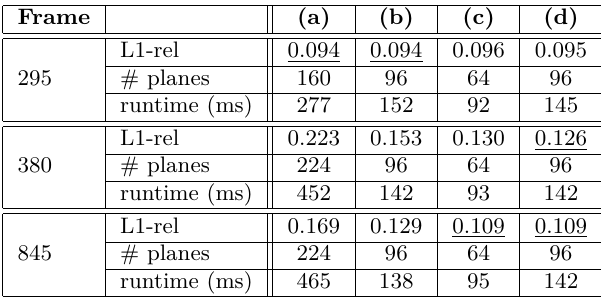
Figure 3. Qualitative evaluation on three sequences of the New Tsukuba Stereo Benchmark (NTSB). Row 1: Frame 295. Row 2: Frame 380. Row 3: Frame 845. Column 1: Reference frame. Column 2: Groundtruth depth map. Column 3: Estimated depth map with linear sampling of 2 units in scene space. Column 4: Estimated depth map with linear sampling of < 1 pixel along the epipolar line in image space. Table 1. Quantitative evaluation between four different configurations on the NTSB. (a) Linear sampling in scene space, with a step size of 2 units. (b) Linear sampling in scene space with 96 planes. (c) Linear sampling in image space with a disparity change of max. 2 pixels. (d) Linear sampling in image space with a disparity change of max. 1